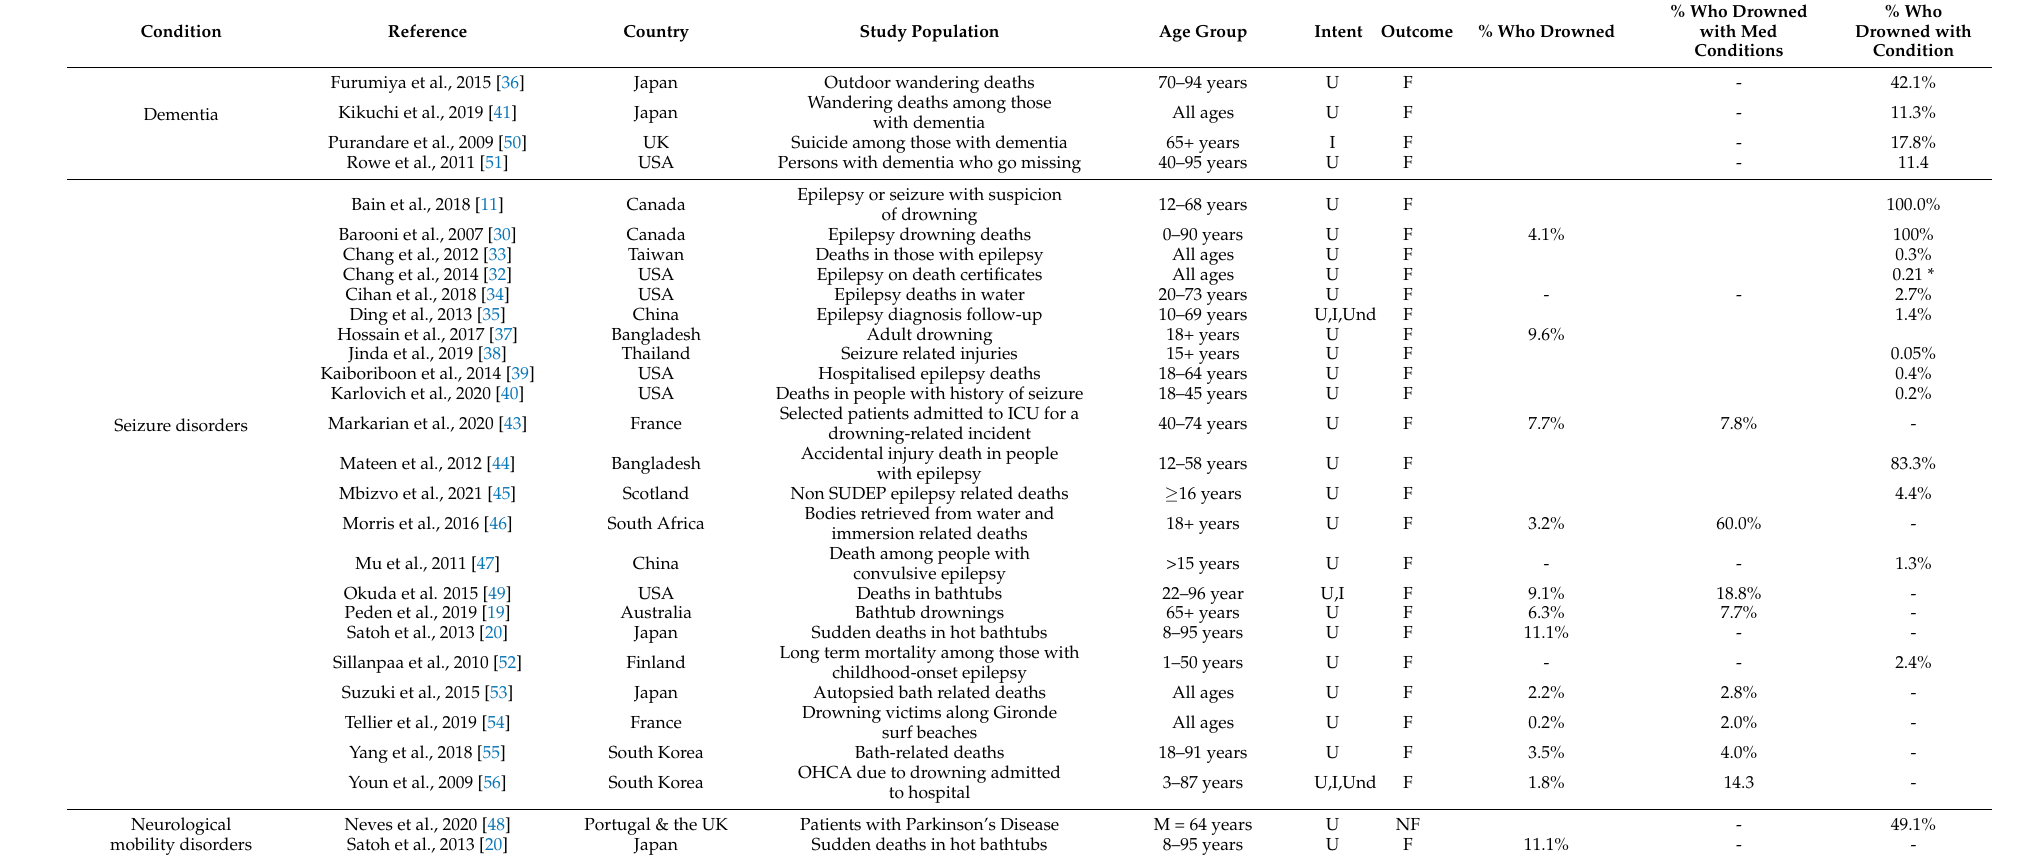
Table 4. Studies reporting conditions within the diseases of the nervous system